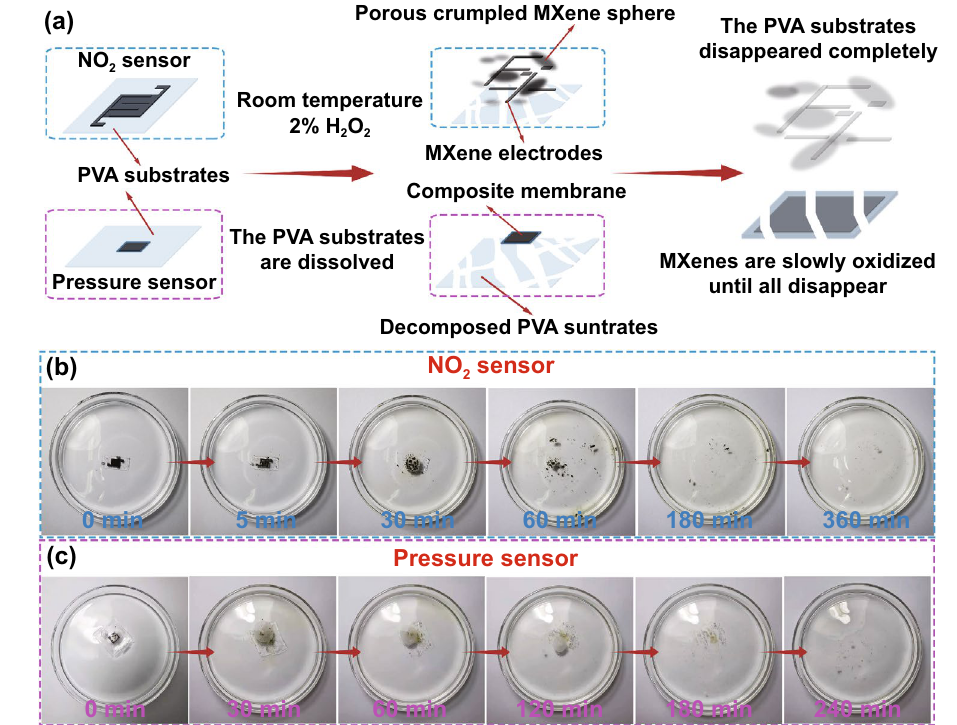
Fig. 6 a Schematic diagram of the degradation process of the transient NO 2 and pressure sensors based on MS-2-10. b The degradation process of the transient NO 2 sensor in 2% medical H 2 O 2 for 6 h. c The degradation process of the transient pressure sensor in 2% medical H 2 O 2 for 4